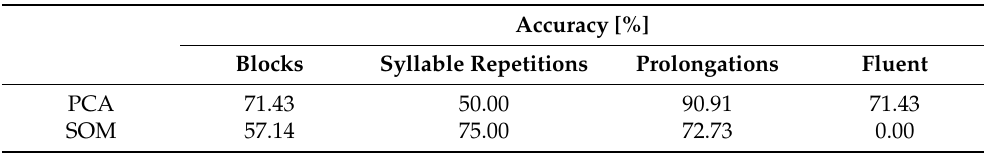
Table 5. Accuracy for examined groups of disfluencies and fluent speech calculated for the test set for PCA and SOM feature extraction